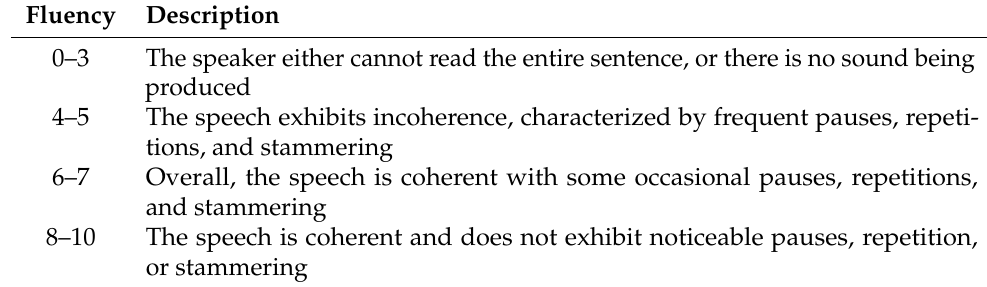
Table 4. Manual scoring metrics of sentence-level fluency on Speechocean762.